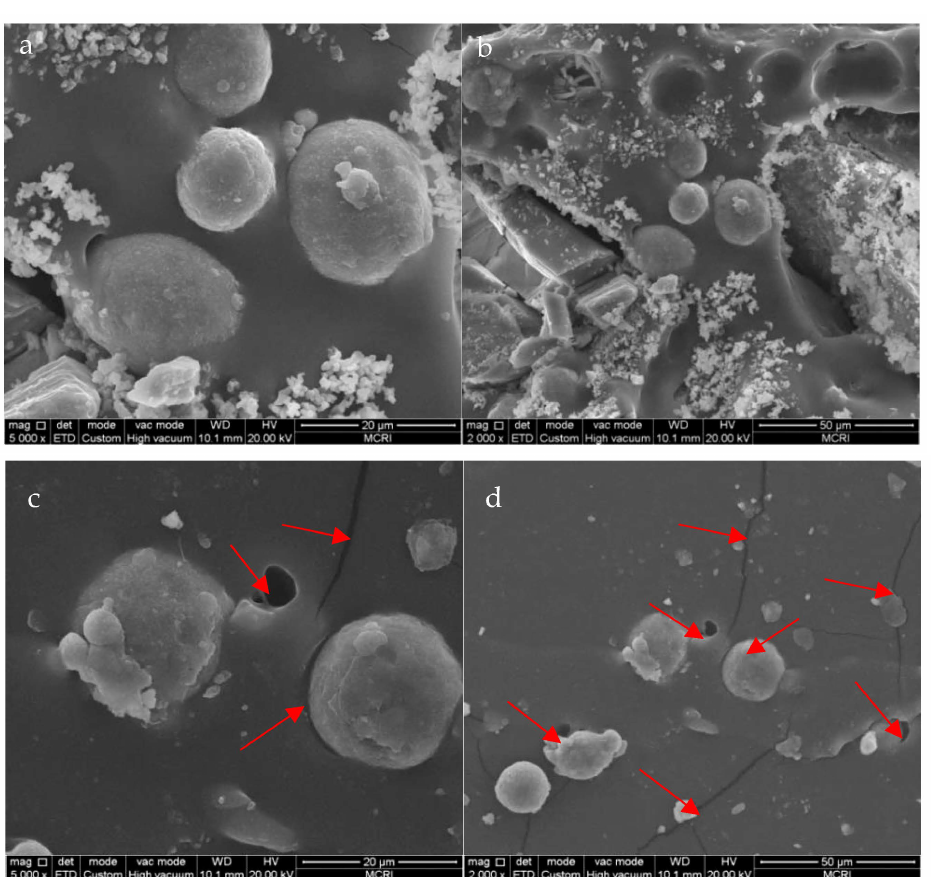
Figure 10. SEM images of freeze-fractured ( a , b ) and tension-fracture ( c , d ) surface of the PET-DA- PU/Al/Na 2 SO 4 composite. (the cracks and voids were marked as red